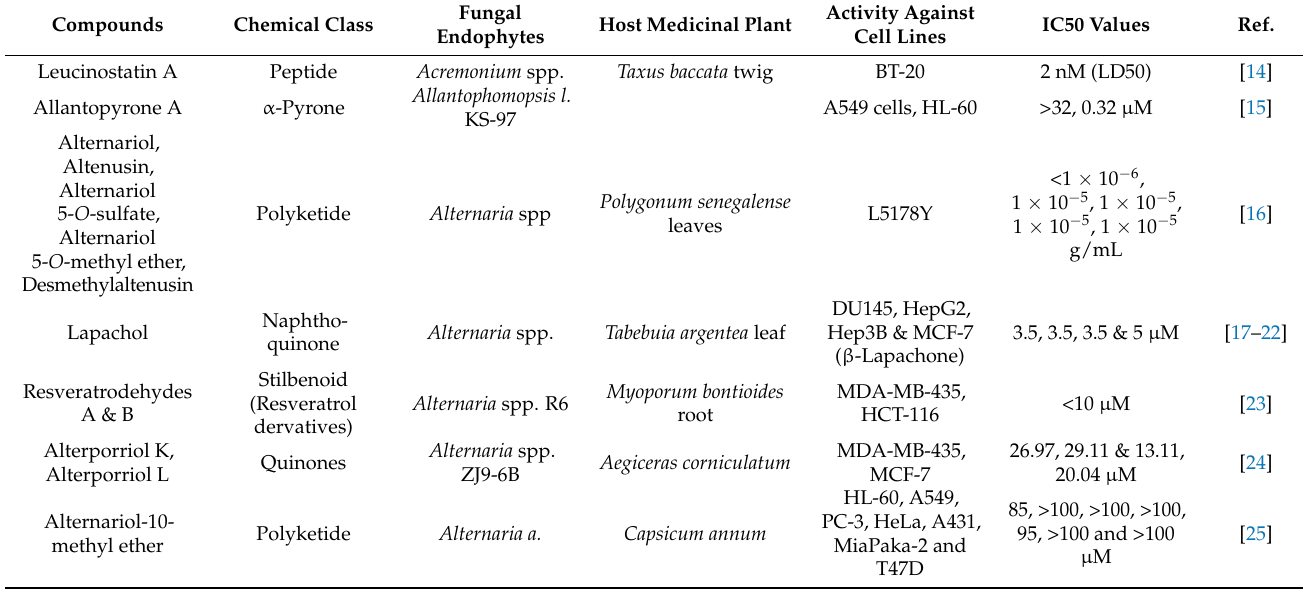
Table 2. Anticancer compounds from plant-derived endophytic